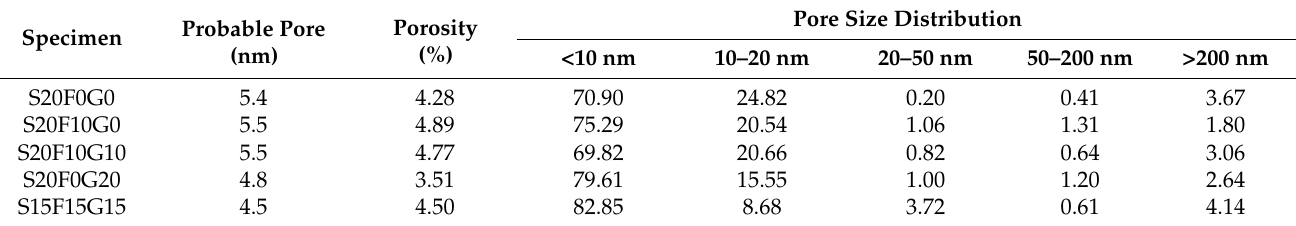
Table 6. The pore structure of EUHPC under steam curing.